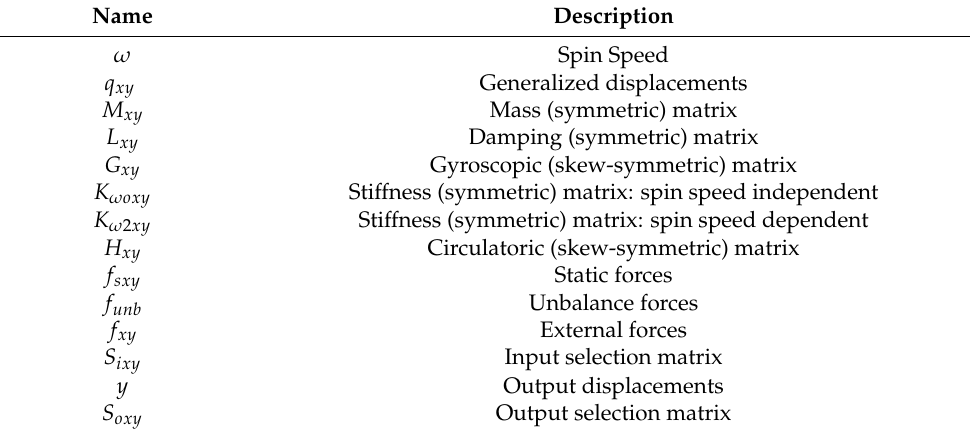
Table 3. Description of the variables.